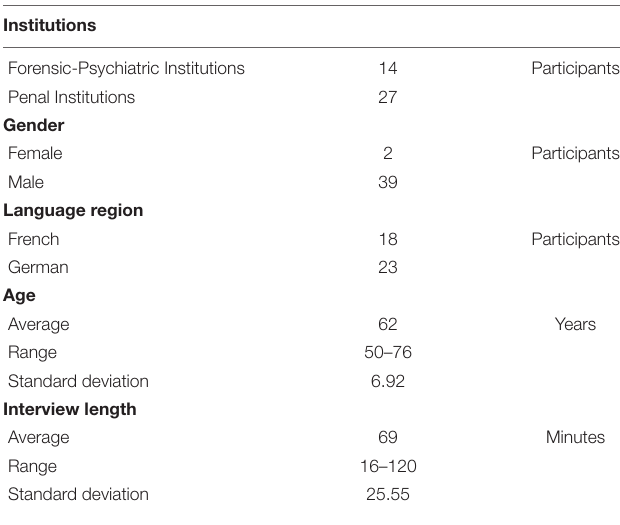
TABLE 1 | Participant characteristics ( N =